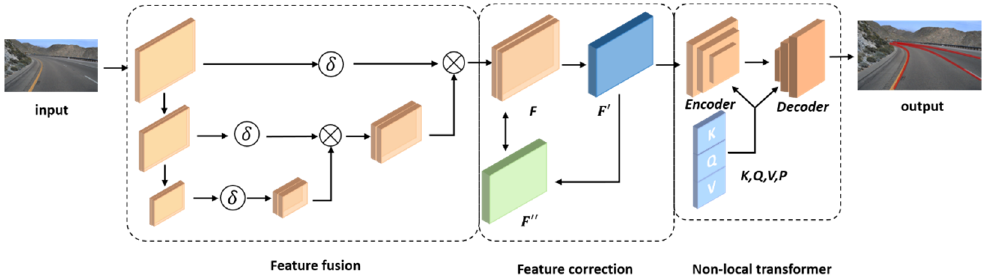
Figure 1. The overall architecture. 𝛿 is a CNN network for further feature extract, ⊗ is feature con ‐ catation. 𝐹 is the finally feature, 𝐹 (cid:4593) is the result of conv processing 𝐹 , and 𝐹 (cid:4593)(cid:4593) is the result of conv concatation. F is the finally feature, F (cid:48) is the result of conv processing F , and F (cid:48)(cid:48) is the result of conv processing 𝐹 (cid:4593) . 𝐾,𝑄, 𝑉,𝑃 represent the key, query, value and position encoding of the transformer processing F (cid:48) . K , Q , V , P represent the key, query, value and position encoding of the transformer network, respectively. network,